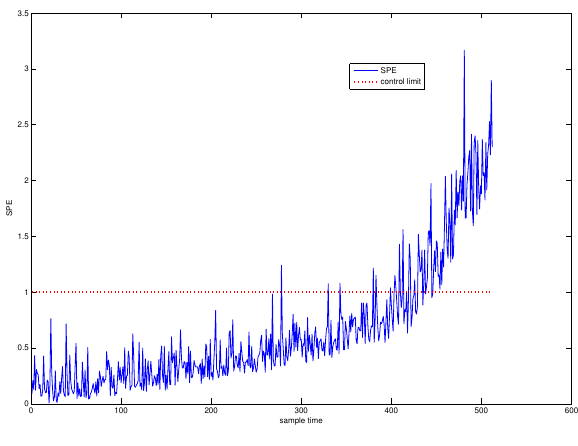
Figure 10. SPE chart for PCA for historical fault observation.